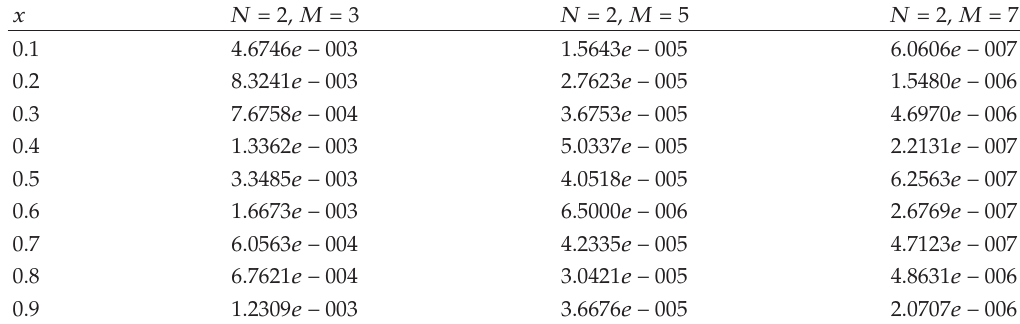
Table 1: Absolute error for α (cid:8) 1 / 2 and di ff erent values of M , N for Example 6.2.